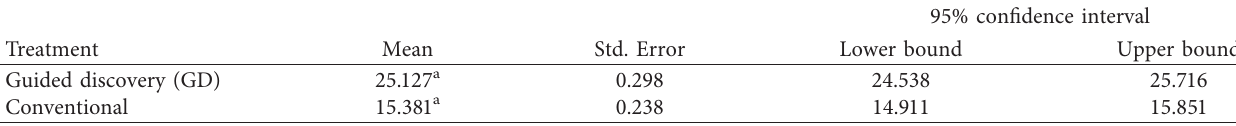
Table 6: Estimated marginal means for retention test by